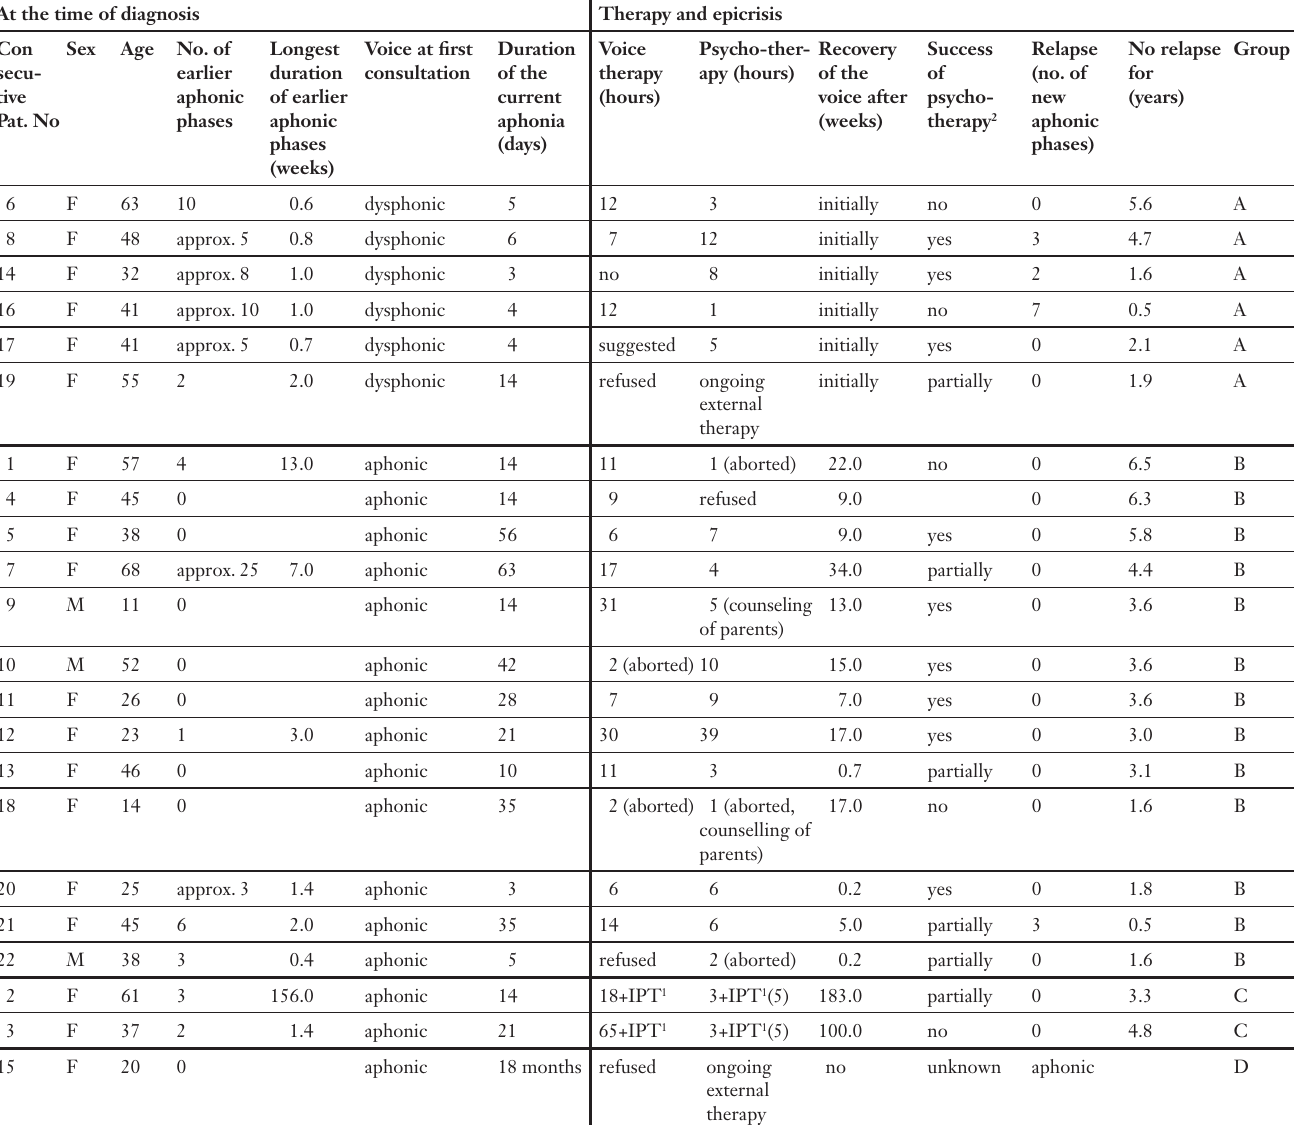
Patients with psychogenic aphonia (n = 22). Data concerning voice and therapy success. ( 1 IPT = in-patient therapy at an external voice clinic. 2 Success of psychotherapy as subjective assessment: “yes“ = psychosomatic context recognized and psychosocial changes initiated; “partial” = psychosomatic context recognized; “no” = psychosomatic context not recognized; “aborted” = patient aborted intervention). At the time of